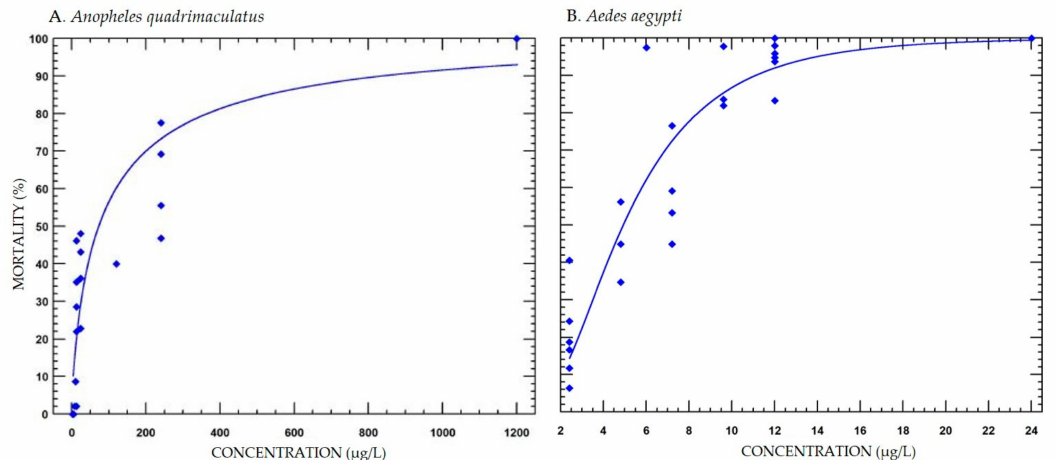
Figure 1. Fitted linear concentration response curves of mortality percentages in Anopheles quadrimaculatus 3rdinstarlarvae(( A ),n = 1–5) andAedesaegypti 2ndinstarlarvae(( B ),n = 1–7)exposedto Bacillusthuringiensis subspecies israelensis for 48 h in glass jars. Each data point represents a replicate with the four jars combined. Curves plotted with PoloPlus (PoloPlus 1.0; LeOra Software, El Cerrito, CA,